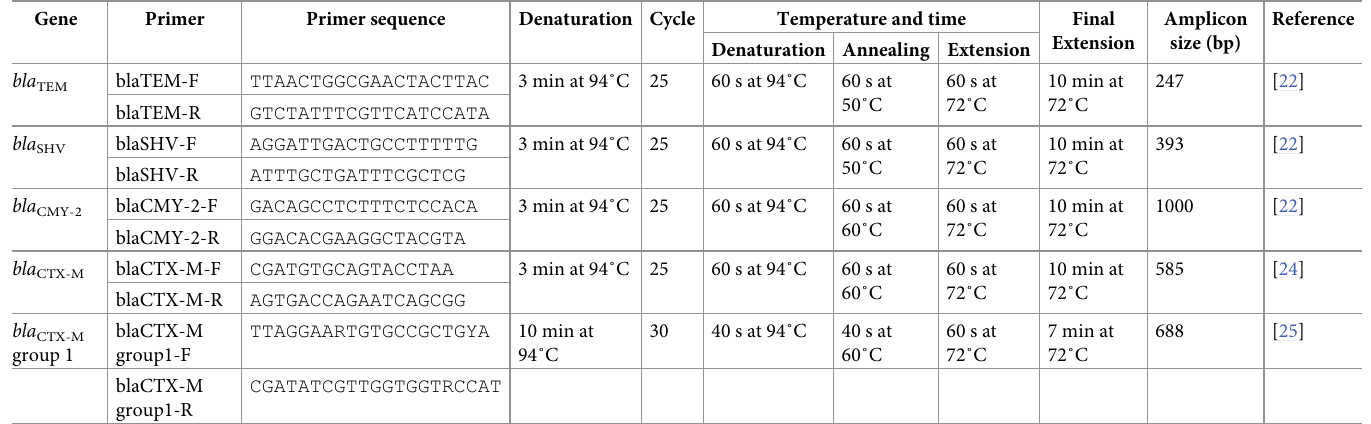
Table 2. Primer used and PCR condition for extended-Spectrum β -Lactamase genes.